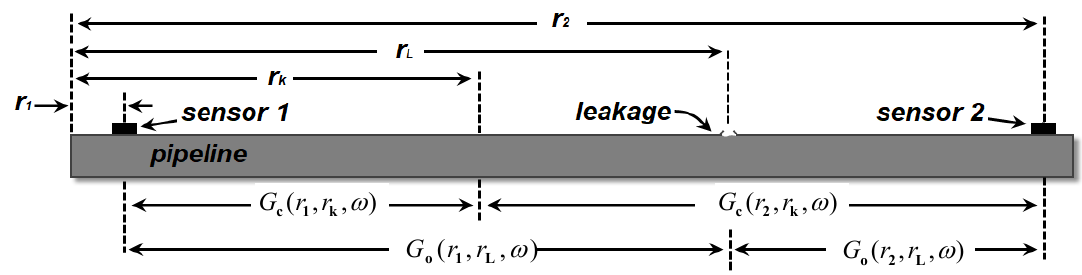
Figure 1. Model of the proposed algorithm.